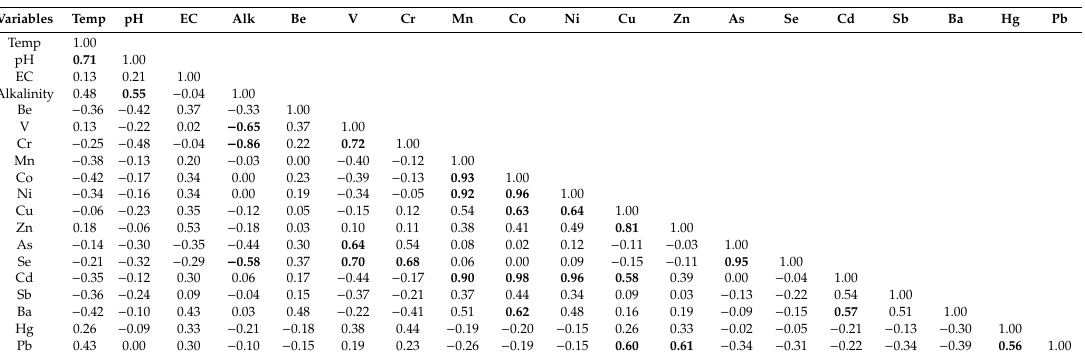
Values in bold are di ff erent from 0 with a significance level alpha =